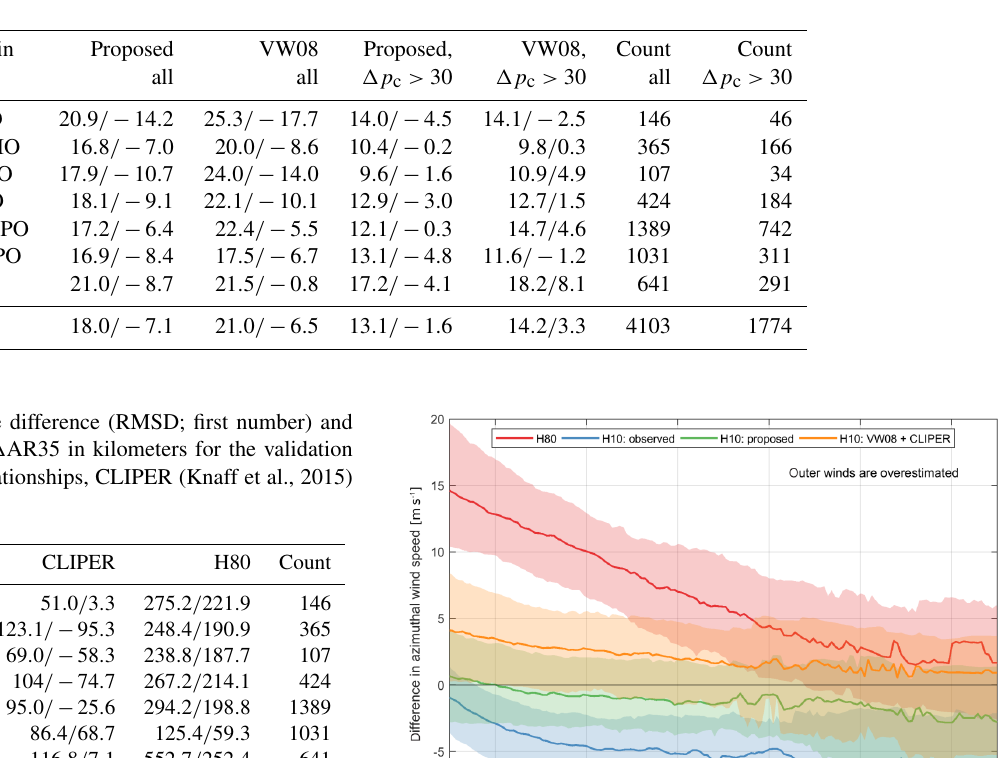
Table 3. Root-mean-square difference (RMSD; first number) and bias (second number) for RMW in kilometers for the validation period for both the proposed relationships as for VW08. Statistics are presented for all data points, as well for data points with a pressure drop ( (cid:49)p c ) larger than 30hPa.